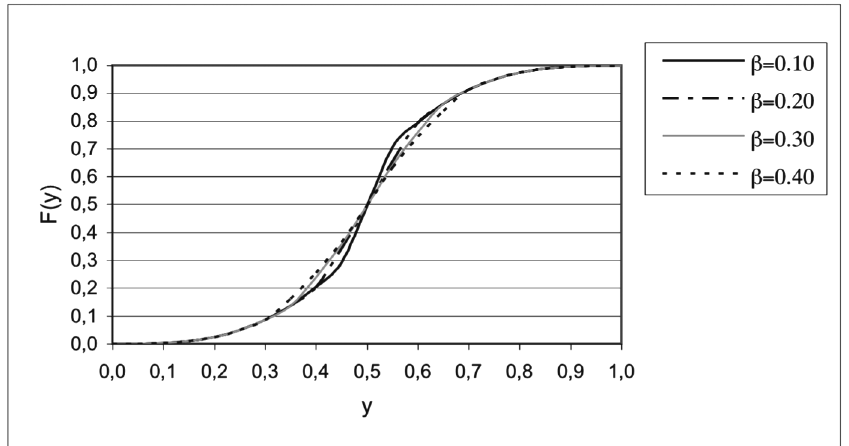
Figure 6 – MTSP cumulative distribution function ( α =0.20 , β